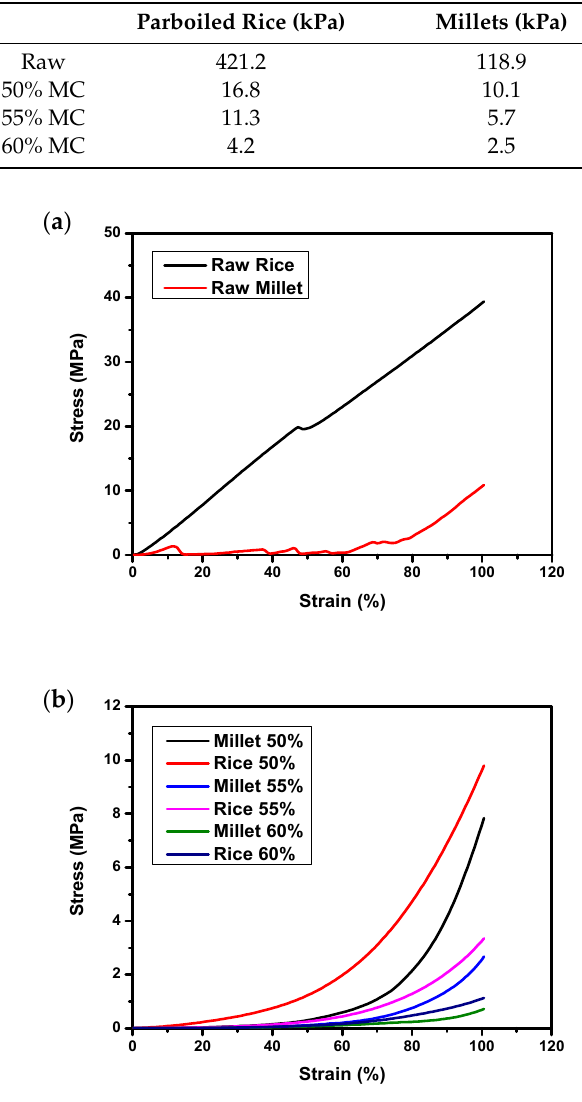
Figure 2. Texture profile analysis of ( a ) raw and ( b ) autoclaved parboiled rice and millet with di ff erent moisture contents.